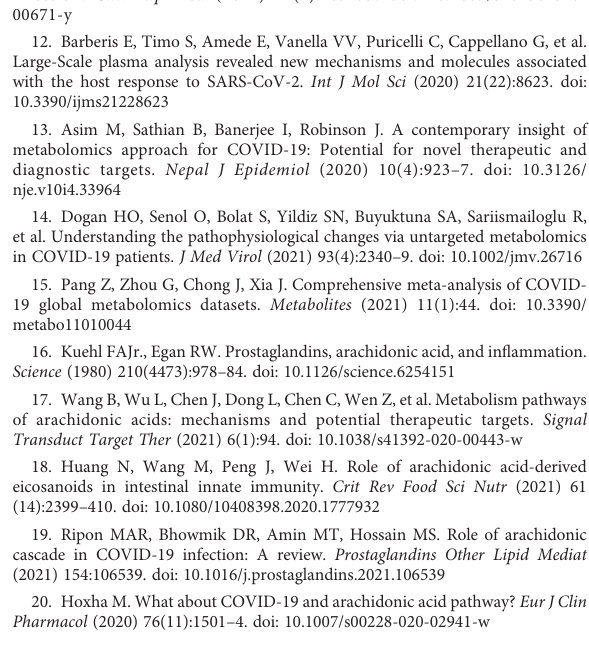
SUPPLEMENTARY FIGURE 1 Sample quality control analysis. The overlapped total ion current (TIC) chromatograms of the quality control sample in the positive (A) and negative (B) modes. (C) . Correlation between replicates was assessed using a Pearson correlation test. D. Principal component analysis shows all samples distribution. HC: healthy control, CAP: community-acquired pneumonia, CP: COVID-19 patients, mix represents quality control sample. SUPPLEMENTARY FIGURE 2 The validation of OPLS-DA model. (A) . The OPLS-DA model for healthy control and COVID-19 patients was validated using permutation test (200 times). 9B) . The OPLS-DA model for community-acquired pneumonia (CAP) patients and COVID-19 patients was validated using permutation test (200 times). SUPPLEMENTARY FIGURE 3 LASSO regression analysis. LASSO regression analysis was applied to screen featured metabolites between the COVID-19, community- acquired pneumonia (A) and healthy control groups (B)